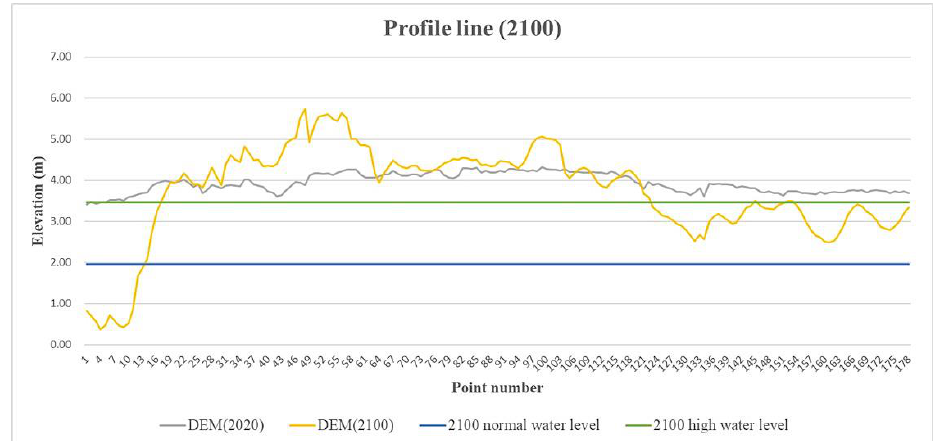
Figure 30. Static display of dam profile and sea-level for 2050. The highest sea-level is 3.46 m and the normal sea-level is 1.96 m. We are able to establish the entry point in the high sea-level scenario in 2100 and find that the northern and southern parts of the dam will lose their protective ability completely.